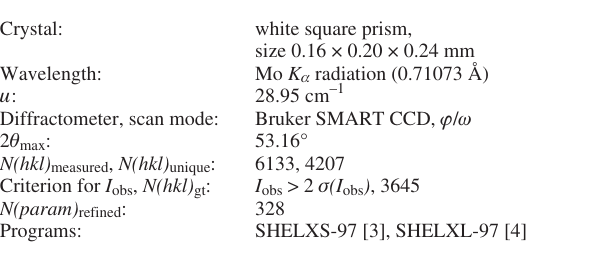
Table 1. Data collection and handling.